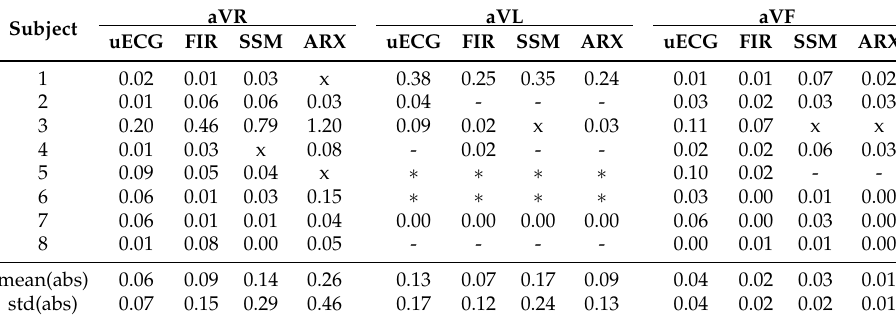
Table A3. Mean squared error for the amplitude deviation of the S waves.